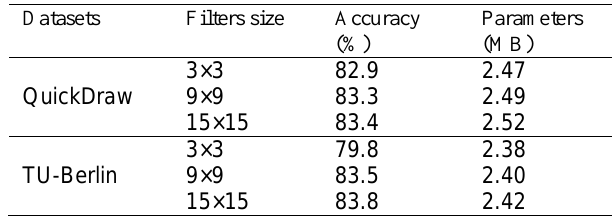
Table 2. Effect of larger first convolutional layer filters